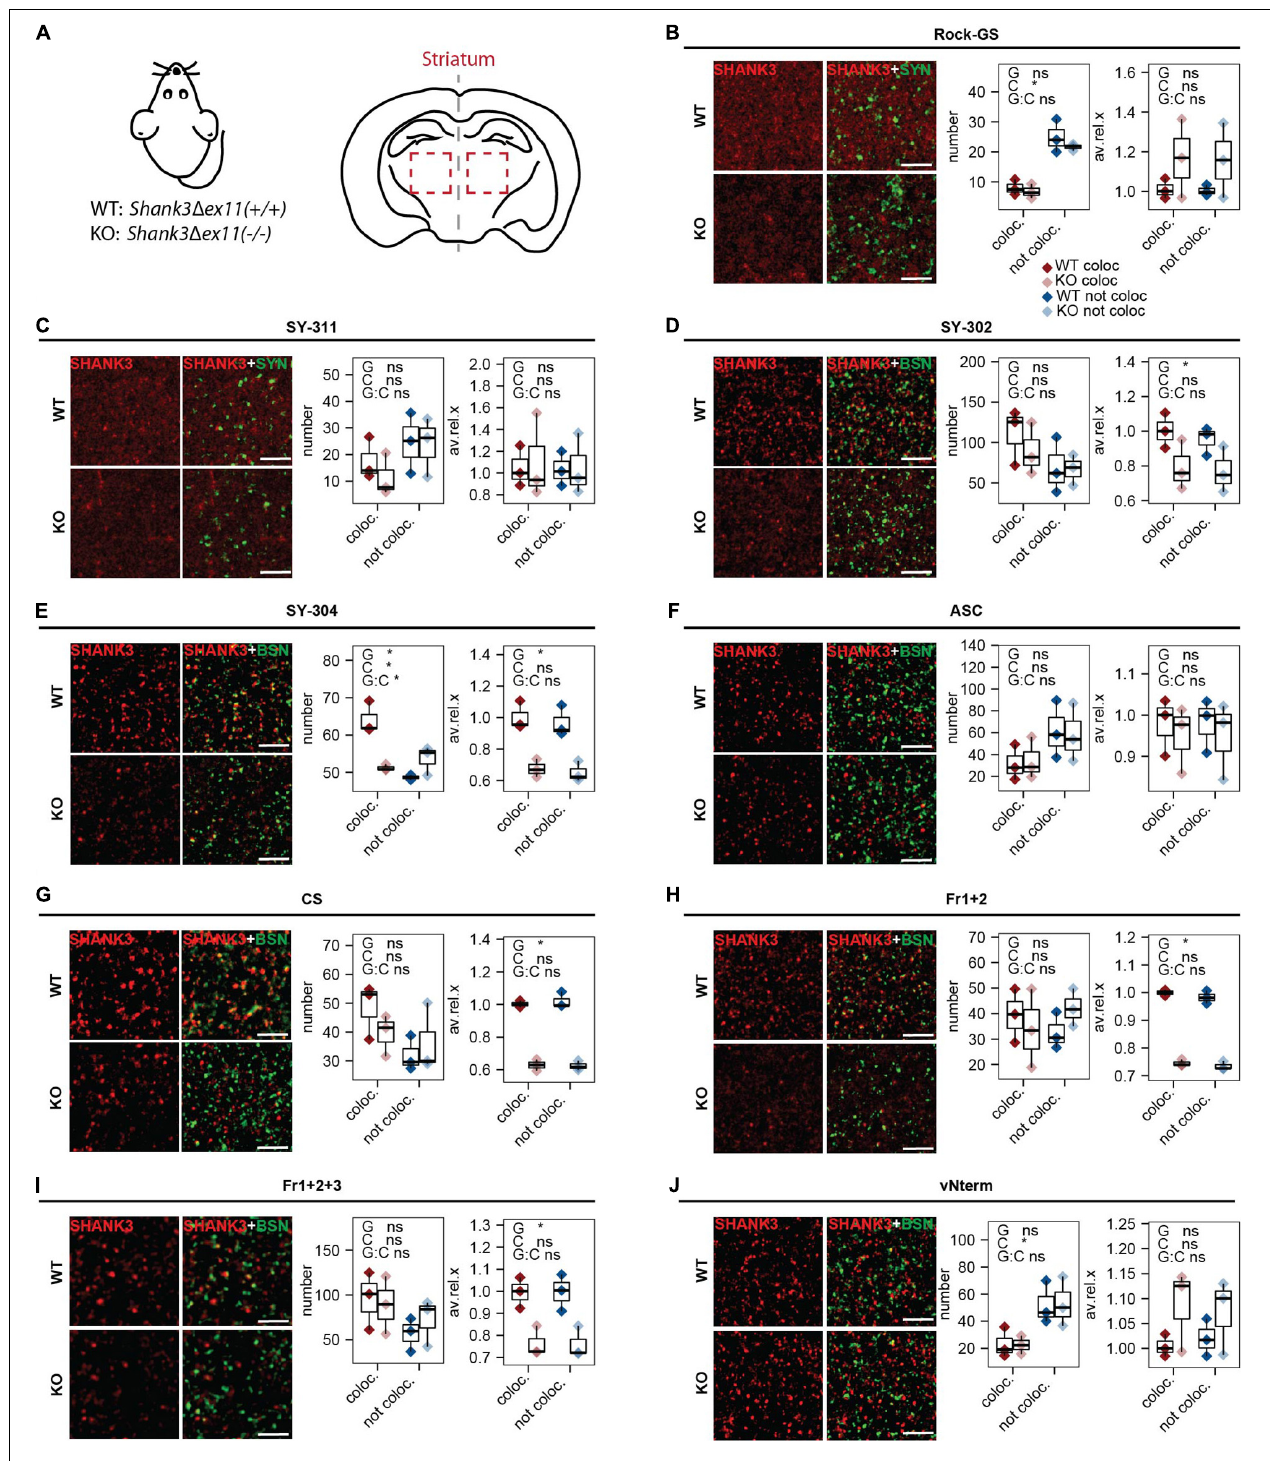
FIGURE 5 | IHC analysis in striatum of mouse brain sections. (A) Sections of WT [ Shank3( + / + ) ] and KO [ Shank3 (cid:49) ex11(–/–) ] mice were analyzed. Sections were stained against SYNAPSIN1/2 or BASSOON and (B) Rock-GS, (C) SY-311, (D) SY-302, (E) SY-304, (F) ASC, (G) CS, (H) Fr1+2, (I) Fr1+2+3, and (J) vNterm. Scale bar 5 µ m. ICC of WT and KO are shown. Left graph: Number of synapses. SHANK3 puncta co-localizing with the respective pre-synaptic marker (red) or not co-localizing (blue) are shown. Right graph: Average intensity of SHANK3 puncta. The boxplot shows the median and the interquartile range, the whiskers cover minimal to maximal values. n = 3 animals per genotype. One-way ANOVA. G: genotype. C: co-localization or not. G:C: correlation of genotype and co-localization. * p ≤ 0.05.